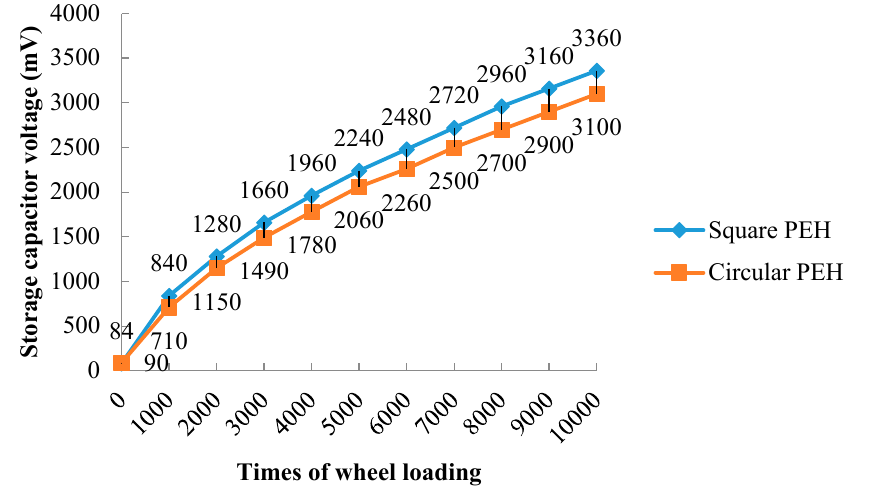
Figure 17. The voltage of the